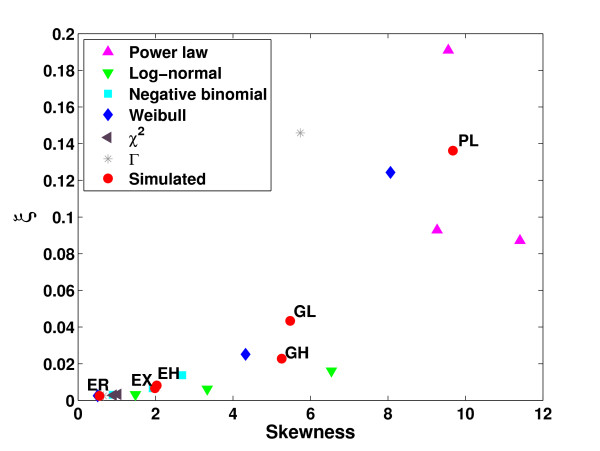
Correlation between ξ and skewness. Values of ξ were computed for a several topology models additional to the ones for which full simulations of our model were performed and plotted against the skewness of the corresponding networks. Topology models considered include power-law, log-normal, negative binomial, Weibull, χ2 and Γ distributions with varying parameters. Parameters were tuned such that average degree values of 10 were obtained and results were averaged over 50 networks generated for each topology. The topology models for which complete simulations were performed are indicated in red.